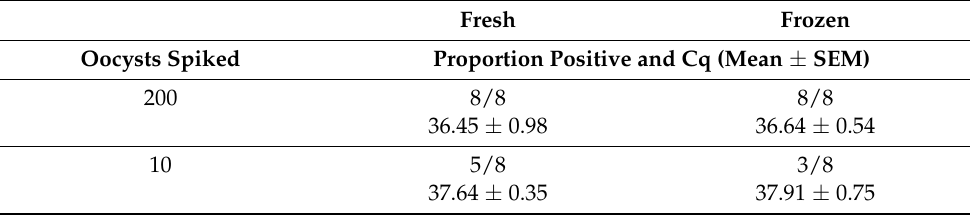
Table 4. Impact of freezing on the detection of Cyclospora in raspberries.